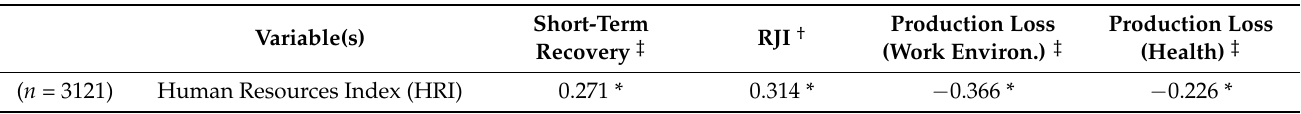
Table 3. Association between HRI and short-term recovery, RJI, work environment related production loss, and health related production loss.